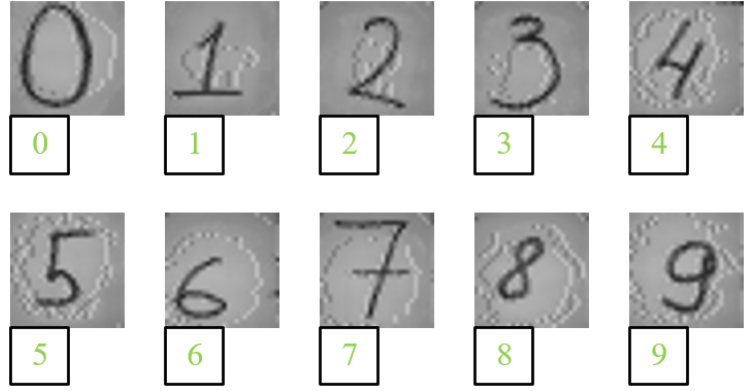
Figure 16. Test result chart.